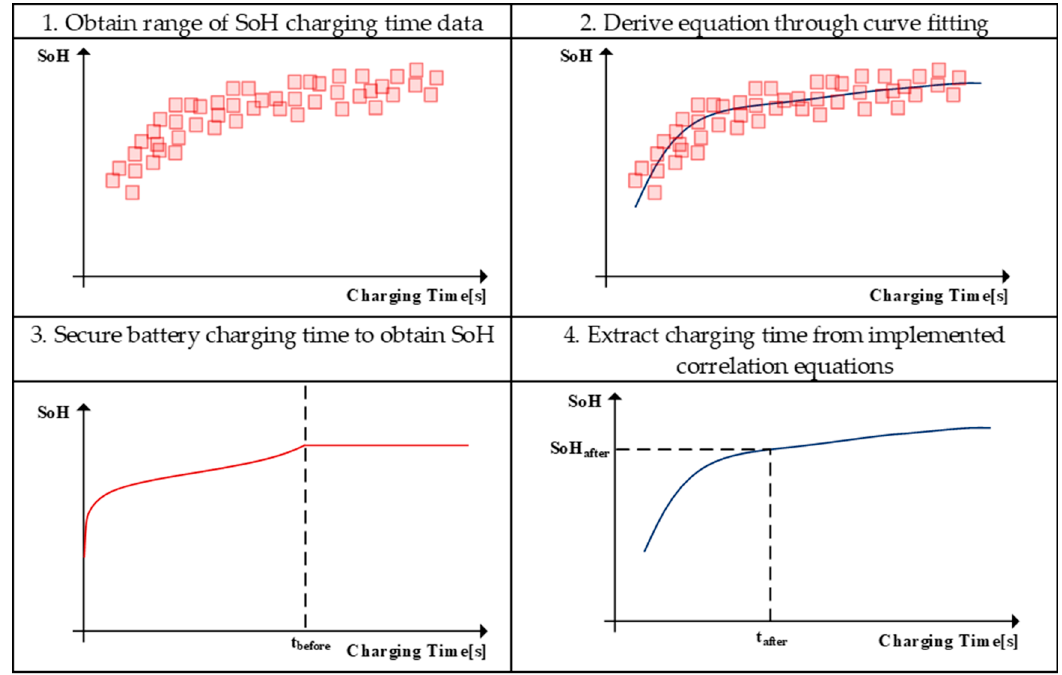
Figure 8. SoH change according to discharging time.